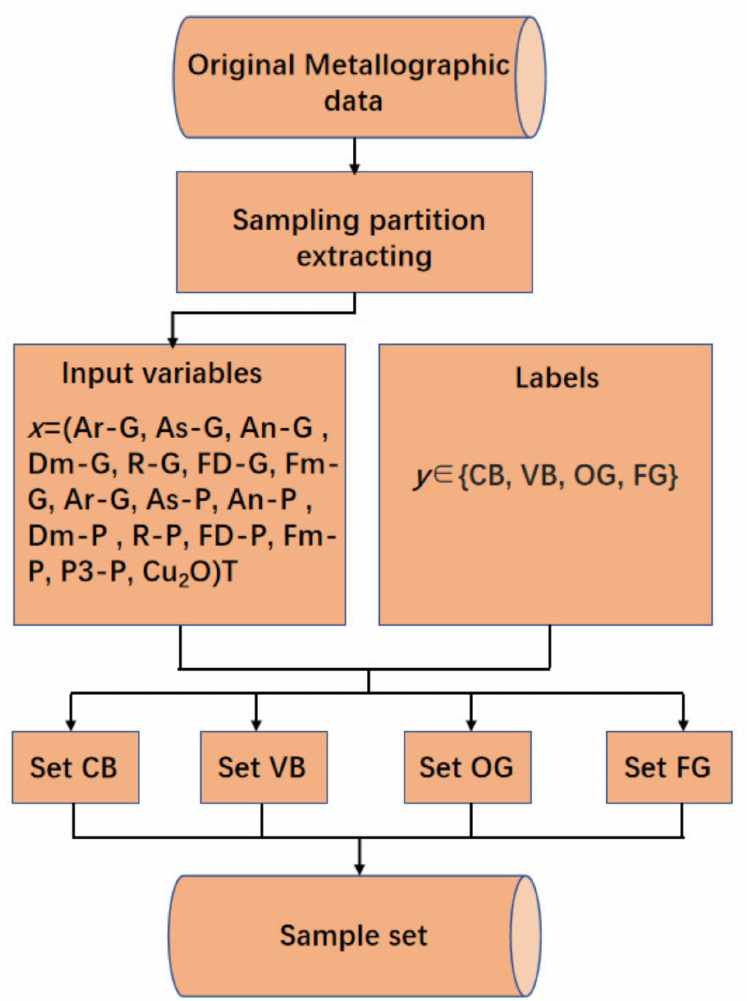
Figure 3. Flowchart of the data preprocessing